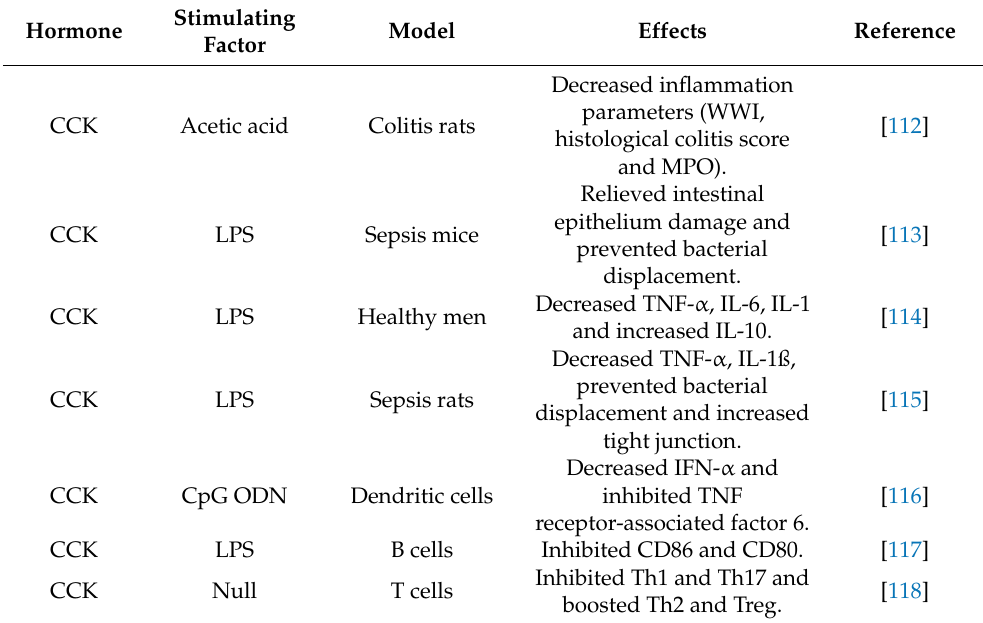
Table 4. Modulation of IBD by